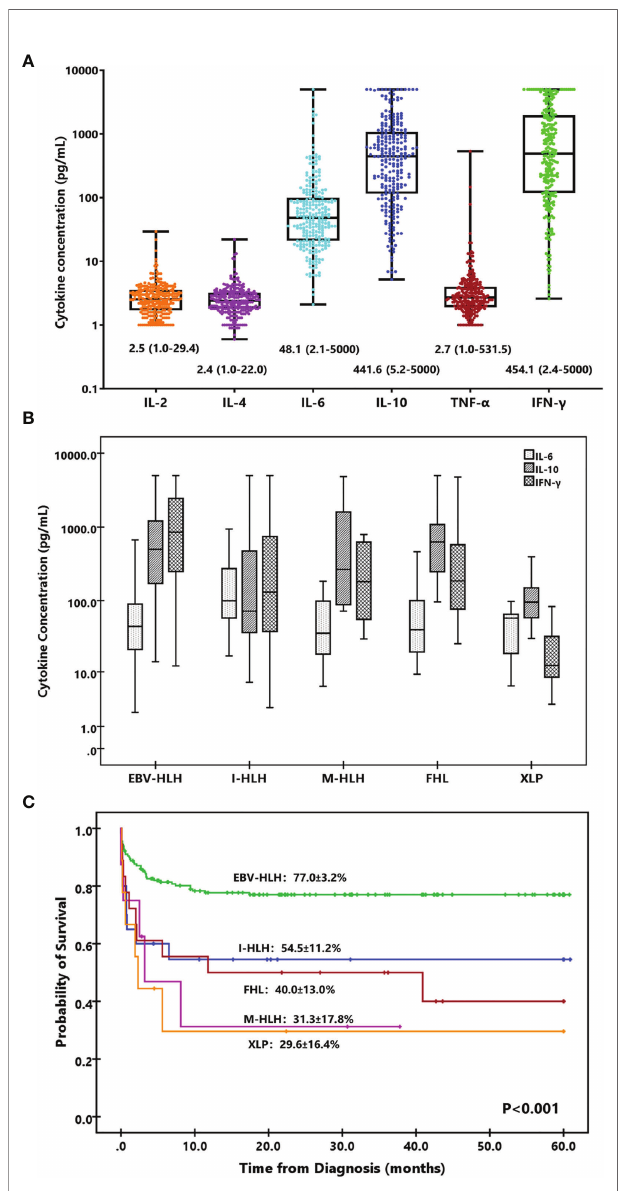
FIGURE 1 | Cytokine levels and cytokine patterns. (A) Box-and-whisker plots of IL-2, IL-4, IL-6, IL-10, TNF- a , and IFN- g levels in HLH. Median levels (lines), 25th to 75th percentiles (box), and minimum to maximum values (whiskers) are shown for each cytokine. The numbers are the median and range of each cytokine. (B) Distinct cytokine patterns of different forms of HLH based on IL-6, IL-10, and IFN- g . Median levels (lines), 25th to 75th percentiles (box), and 5th to 95th percentiles (whiskers) are shown for each cytokine. (C) Kaplan – Meier survival curves for 5-year overall survival (OS) of the patients with different subtypes of HLH. I-HLH, infection-associated HLH triggered by pathogens other than EBV; M-HLH, malignancy-associated HLH; FHL, familial HLH; XLP, X-linked lymphoproliferative